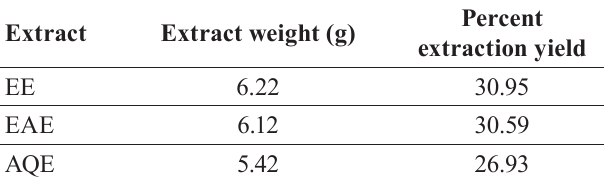
TABLE I - E xtraction yield from different seed extracts Extract